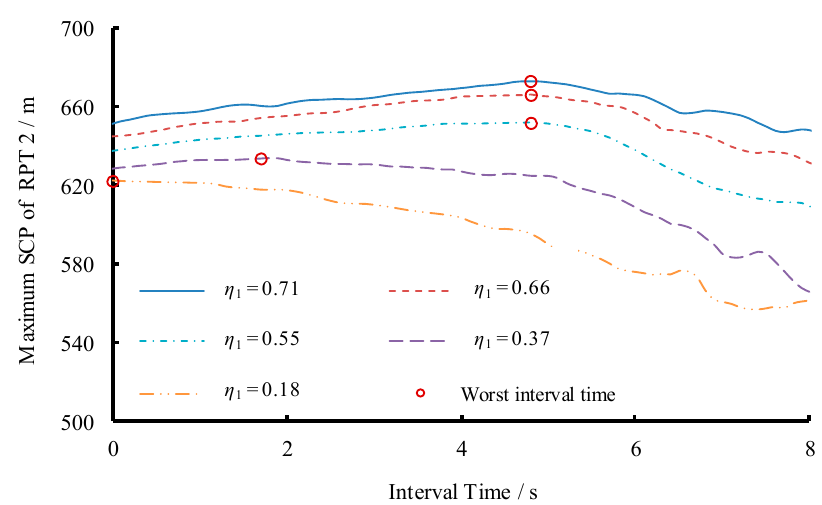
Energies 2019 , 12 , x FOR PEER REVIEW Figure 7. Maximum SCP with different time intervals of different η 1 for Scenario 1. Figure 7. Maximum SCP with di